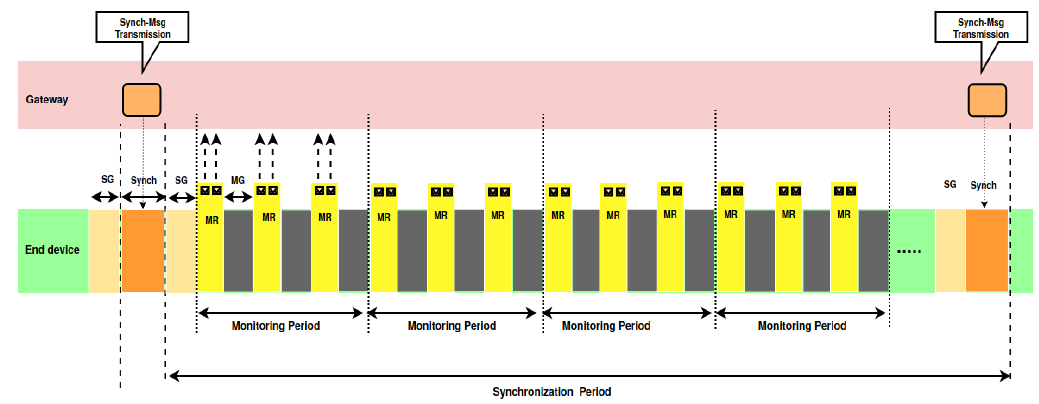
Figure 2. Medium activity over